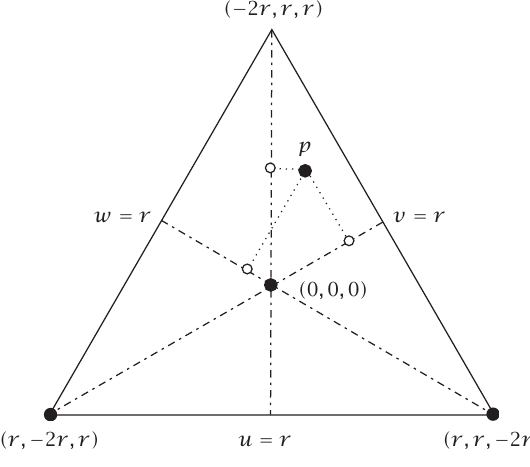
Figure 3.1 . Triangular coordinate